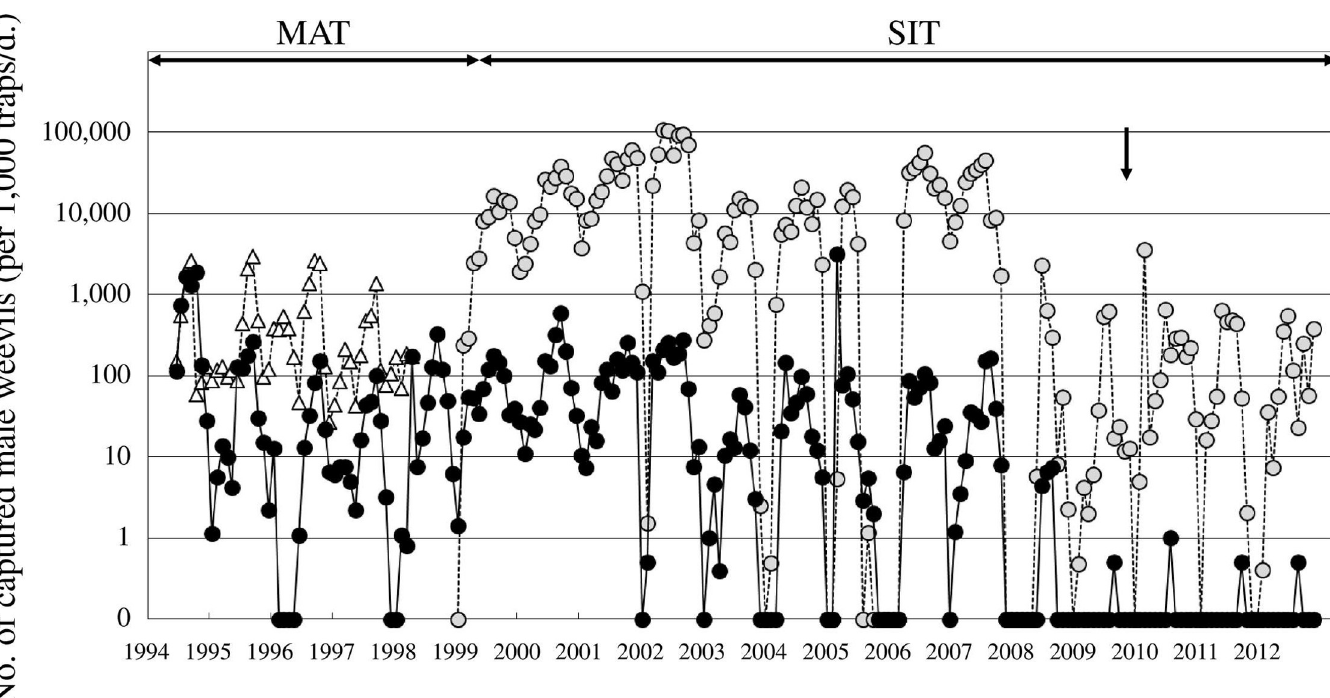
Fig 4. Number of captured male weevils C . formicarius per thousand traps per day in Kume Island. Black circles indicate wild weevils (unmarked)in the MAT and SIT application area. White trianglesindicate wild weevils in the non-MAT application areas. Gray circles indicate marked weevils (from January 2010, we used the phenotypic marker; the piceous elytra of the PE strain) in the SIT application area. The black arrow indicatesthe initiation of the release of the PE strain for SIT application in January 2010.